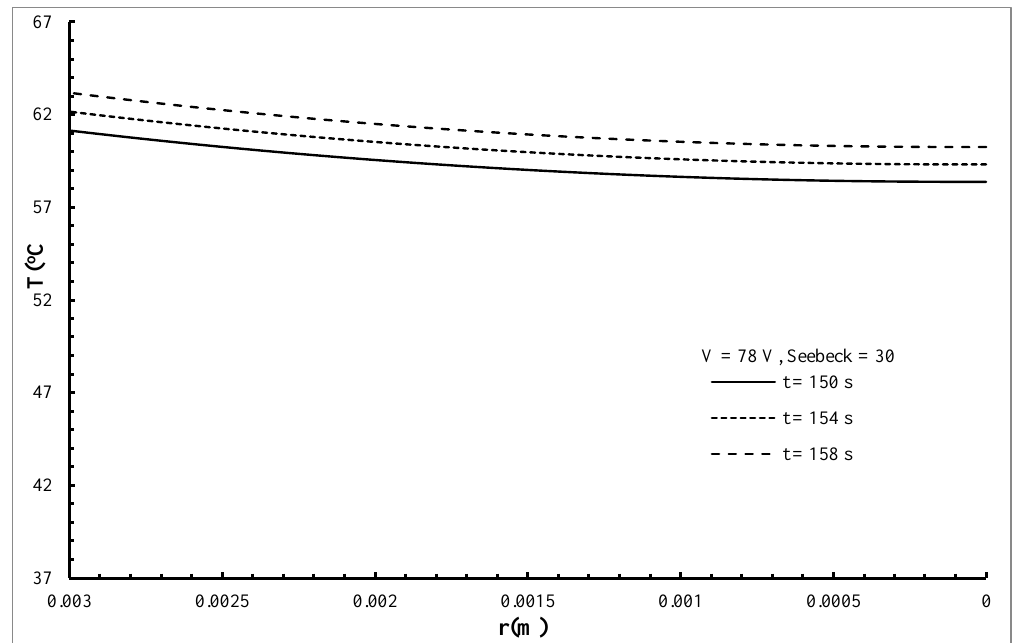
Figure 9 . The absolute temperature distribution of liposarcoma tumor with various values of time Figure 9. The absolute temperature distribution of liposarcoma tumor with various values of time R   . when 600 when R e = 600 Ω . e